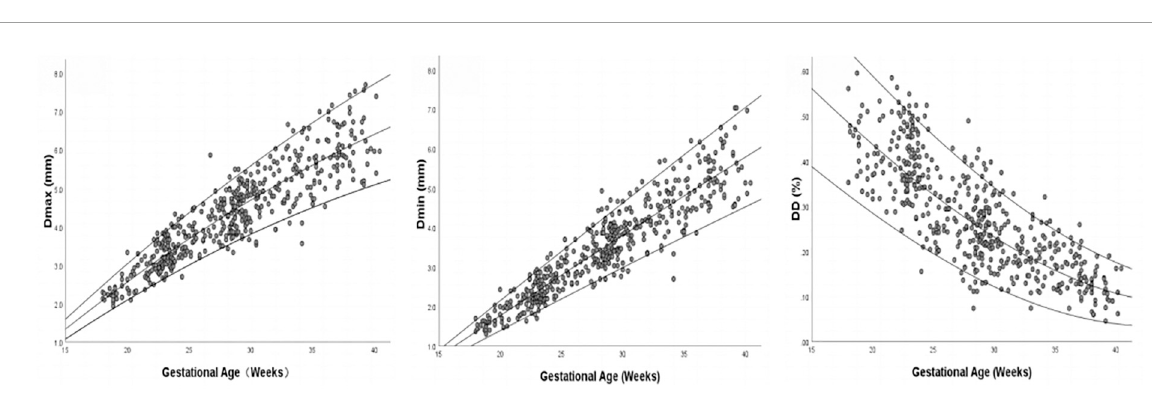
when Z-score is within the ± 1.65 range, the greater the absolute value of Z-score, the greater the deviation from the mean, although it remains within the normal range.